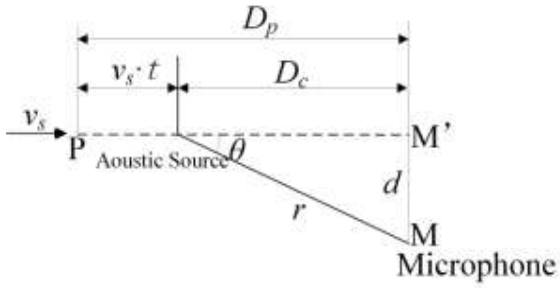
Figure 1. The basic kinematic model of a single acoustic source